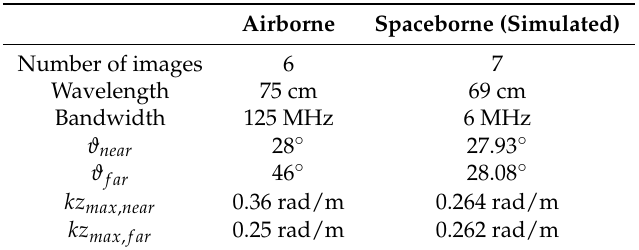
Table 2. Parameters of the P-band airborne radar used in the ONERA TropiSAR survey over Paracou and simulated spaceborne